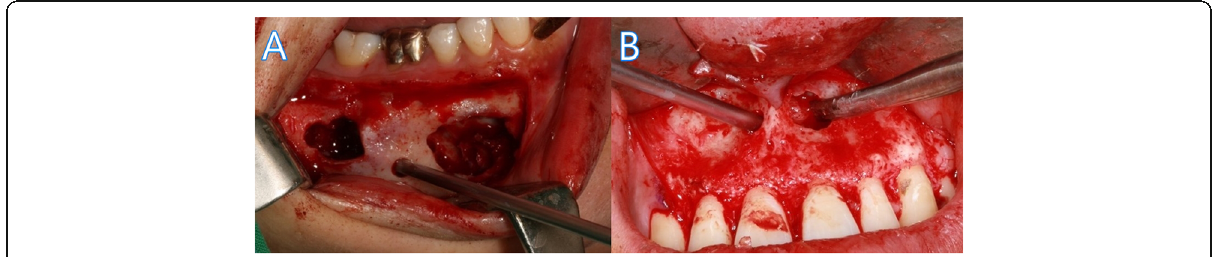
Fig. 2 Radicular cyst enucleation with insertion of the endoscope. A Group 1 intact cortical bone: made two bony holes for enucleation instrument and additional channel for endoscope. B Group 2 cystic bony wall penetrated: penetrated bony wall for enucleation instrument and additional channel was made for